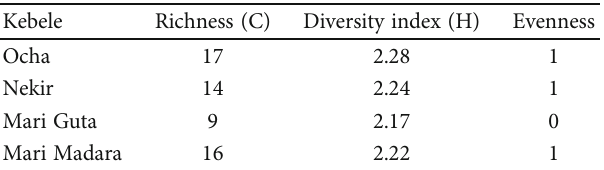
Table 5: The richness ( C ), evenness ( E ), Simpson ( D ), and Shannon ( H ) indices were used to assess the diversity of landraces in the study